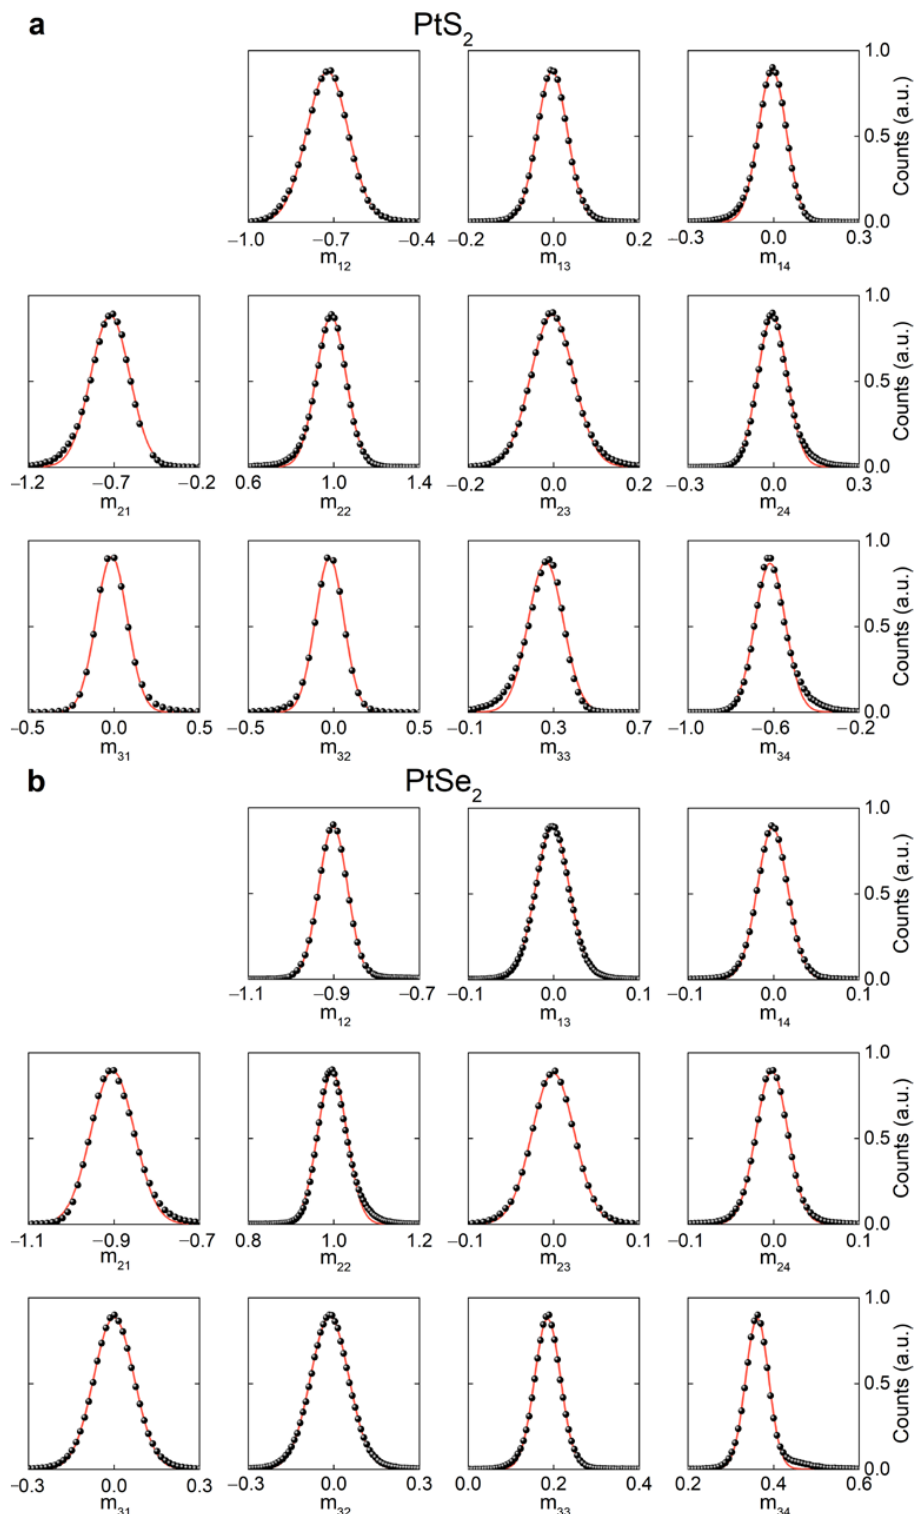
Figure A1. Distribution of Mueller matrix values. ( a ) PtS 2 and ( b ) PtSe 2 . Mueller Matrix values recorded at 50° and λ = 532 nm. Relative frequency of Mueller matrix values follows Gaussian distribution (red line) with zero average for non-diagonal blocks (m 13 , m 14 , m 23 , m 24 , m 31 , m 32 ), thus validating isotropic in-plane response.